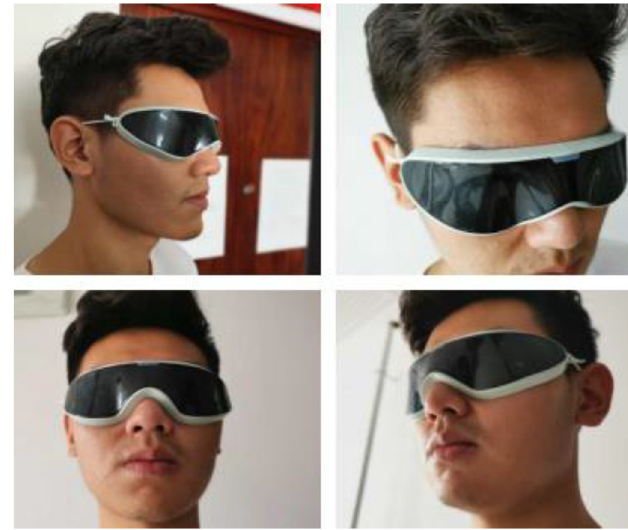
Fig. 24. Validation of the designed swimming